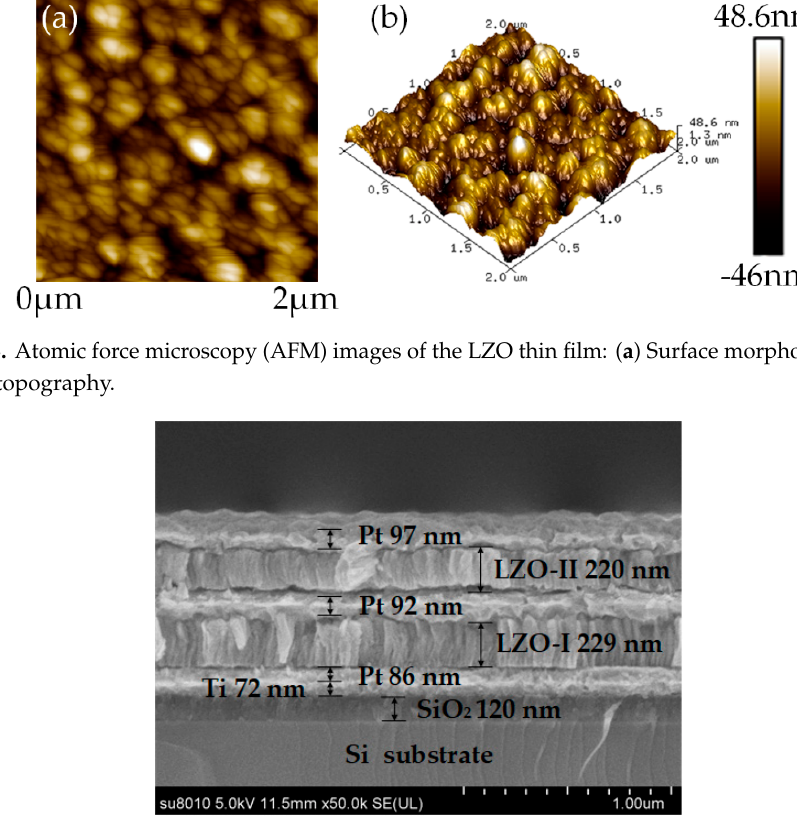
Figure 9. Scanning electron microscope (SEM) cross-section image of the sensor .